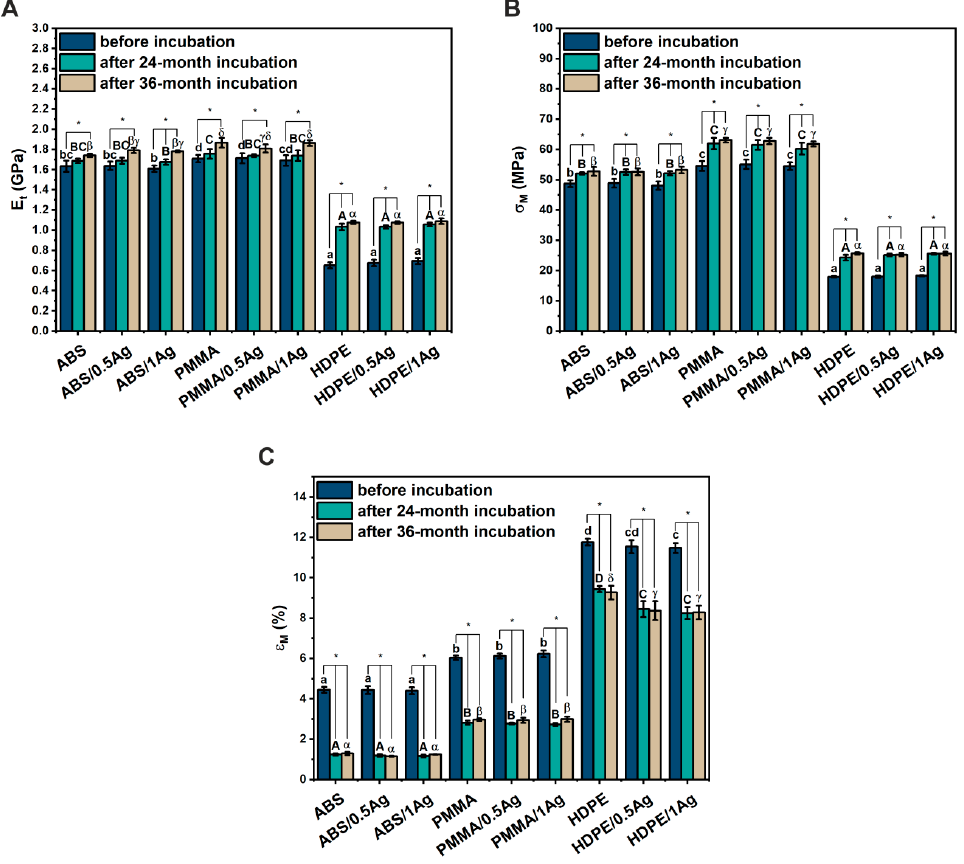
Figure 5. Young’s modulus ( A ), tensile strength ( B ) and elongation at maximum force ( C ) of polymers and composites modified with 0.5 wt.% and 1.0 wt.% AgNPs. Statistically significant differences ( p < 0.05) between different materials before and after the 24- and 36-month incubation periods are indicated by subsequent lowercase and uppercase Latin letters and Greek letters, respectively. Different letters indicate statistically significant differences. Statistically significant differences ( p < 0.05) between materials before and after the 24- and 36-month incubation periods are indicated by asterisks (*). Table 3. Results of the Young’s modulus of polymers and composites modified with 0.5 wt.% and 1.0 wt.% AgNPs. Young Modulus E t (GPa) Material Before Incubation After 24-Month Incubation After 36-Month Incubation